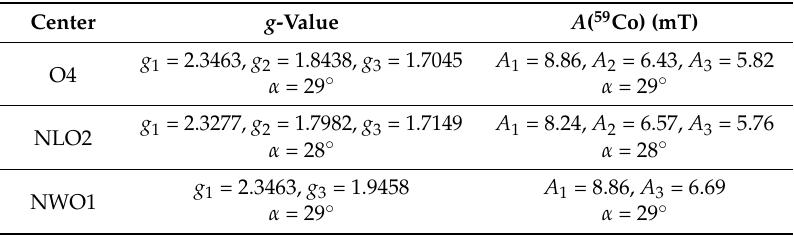
Table 4. EPR parameters for the cobalt-containing centers with S = 1/2 in diamond [22]. g 2 , A 2 corresponds to (011), and α is the angle between g 1 , A 1 and (100).